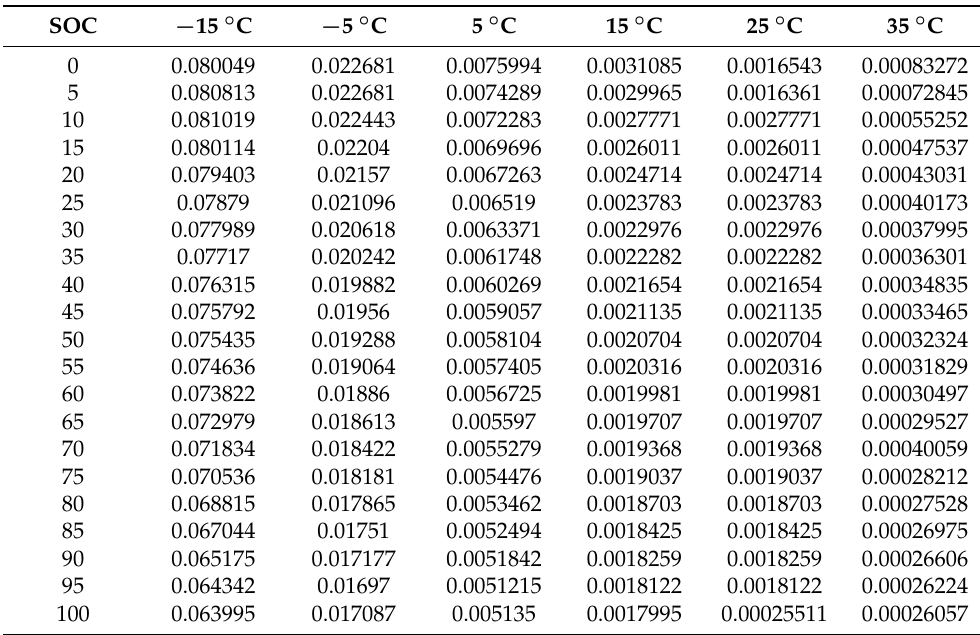
Table A3. Values for parameter R 1 in Ω of electrical model shown in Figure 2 in dependence of cell temperature and